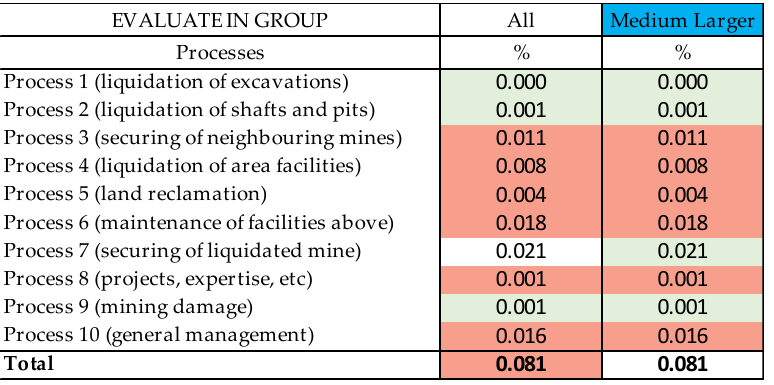
Figure 8. Assessment of the hypothetical branch B21 with random values of the liquidation cost of Medium Larger Branches (MLB).